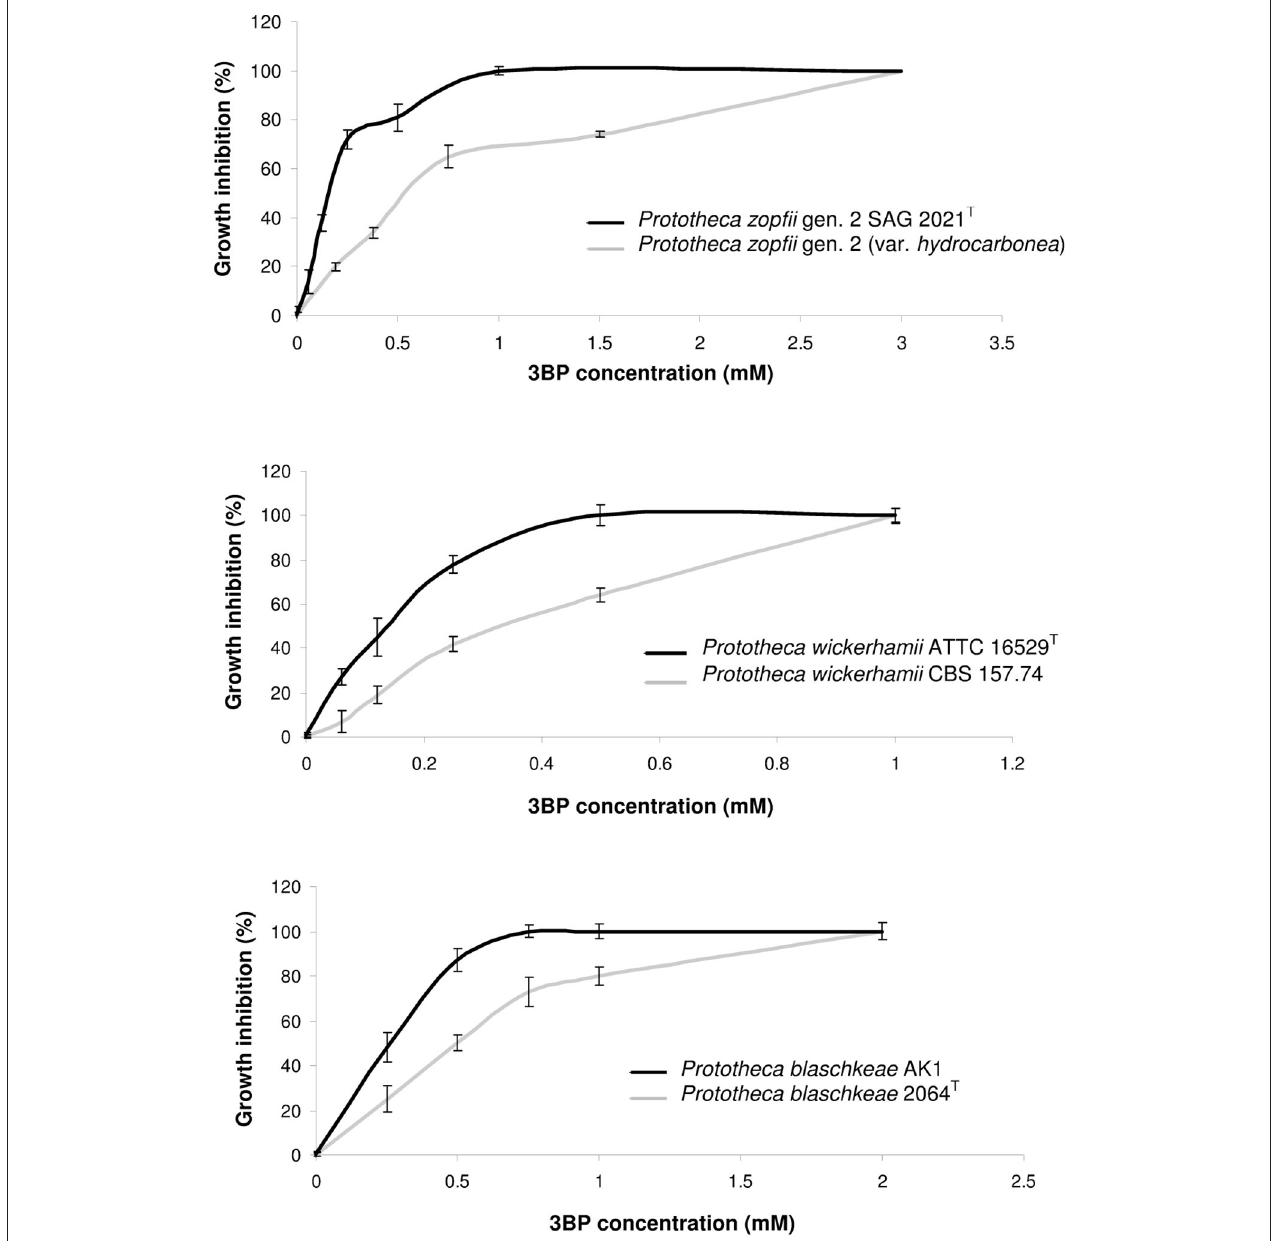
FIGURE 1 | Dose-dependent inhibition of growth and proliferation of cells in case of different Prototheca spp.